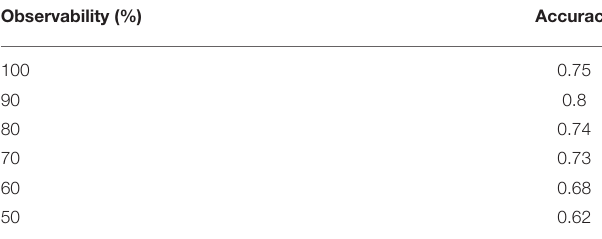
TABLE 1 | Experiment 1